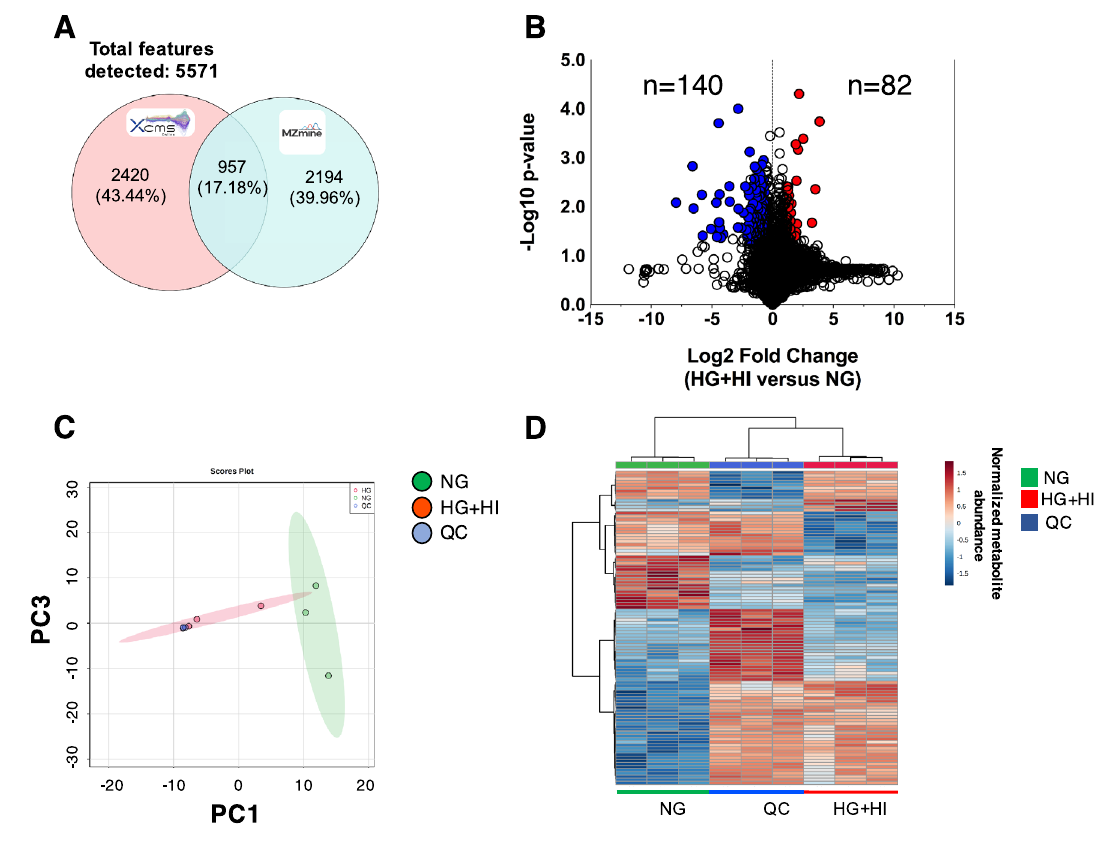
Figure 2. Simulated diabetes induced changes in the metabolome of bovine coronary artery endothelial cells (BCAEC). ( A ) Venn diagram of features identified among MZmine and XCMS software (0.01 Da and 1 min retention time, thresholds) on LC–MS 2 datasets. ( B ) Volcano plot of all quantified metabolites displaying differences in relative abundance (> ± 30% change, < 0.05 p value cut-offs) between BCAEC cultured in control (NG) media and simulated diabetes (HG + HI) for twelve days. Values (dots) represent the HG + HI/NG ratio for all metabolites. Red and blue dots denote downregulated and upregulated metabolites in the HG + HI group versus NG group, respectively. ( C ) Principal Component Analysis (PCA) of LC–MS 2 datasets. Data was log transformed without scaling. Shade areas depict the 95% confidence intervals. ( D ) HeatMap of the top 100 metabolites ranked by t-test. Abbreviations: NG normal glucose, HG high glucose, HI high insulin, QC quality